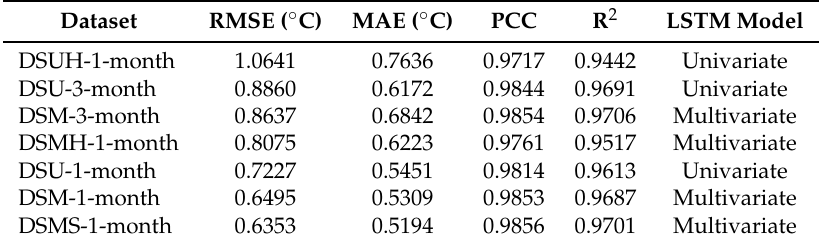
Table 3. Results obtained applying univariate and multivariate LSTM models to the datasets according to the different datasets and configurations of the input variables. For each dataset, the Root Mean Square Error (RMSE), the Mean Absolute Error (MAE), the Pearson Correlation Coefficient (PCC), and the determination coefficient (R 2 ) are provided. Results ordered from highest to lowest